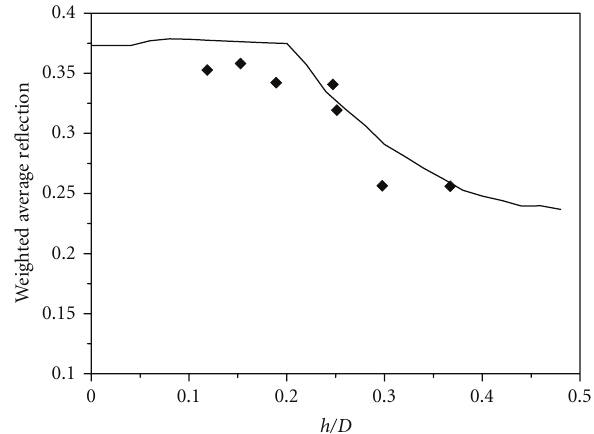
Figure 9: Simulated (solid line) and measured ( (cid:3) ) WAR values, computed using the wavelength range of 300 nm to 1200 nm, as a function of h / D .